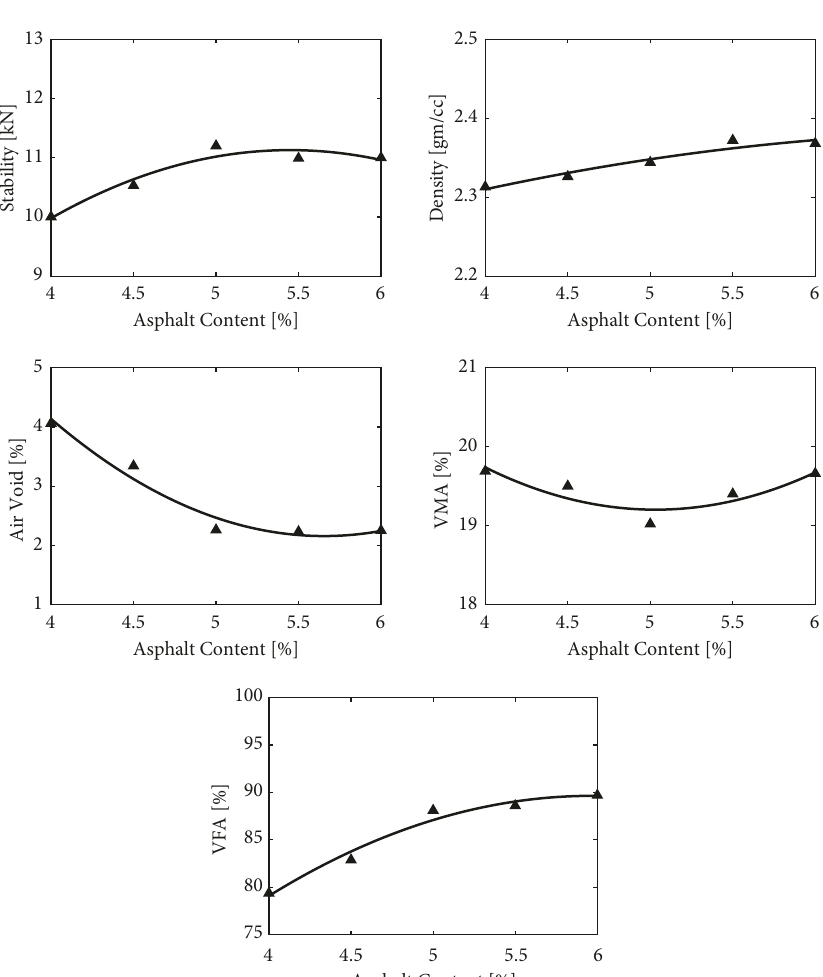
Figure 8: Variation of softening point